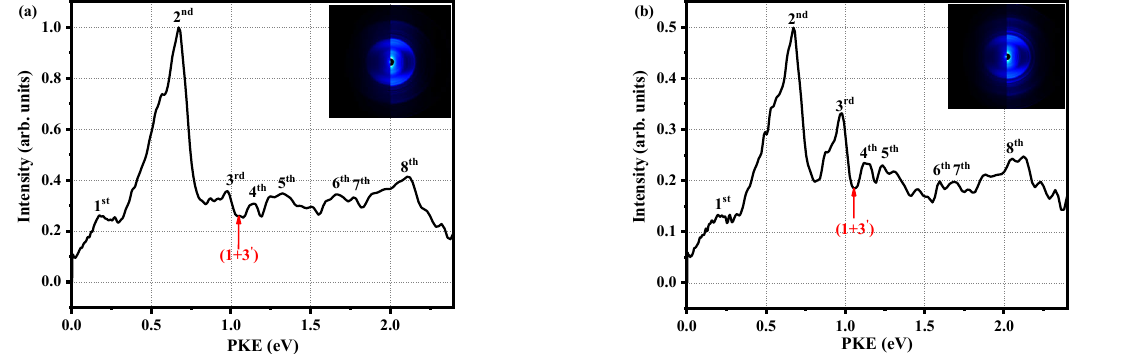
Figure 4. Photoelectron spectra at delay times of ( a ) Δ t = 0.027 ps and ( b ) Δ t = 1.429 ps. The ordinates of the two plots are normalized, and ( b ) is normalized with the maximum value of ( a ) as a reference. The insets are the corresponding optoelectronic images (the original image on the left and BASEX transformed image on the